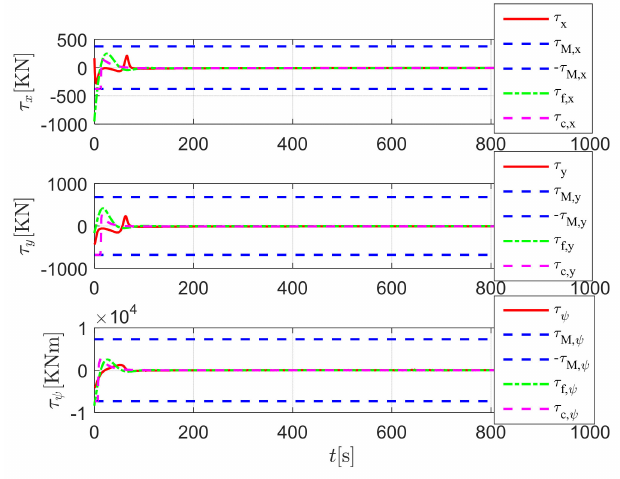
Figure 14. The time response curves of the output of the control laws in Case 1.